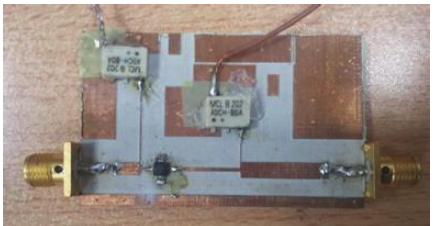
Figure 9: Fabricated UWB low noise amplifier.